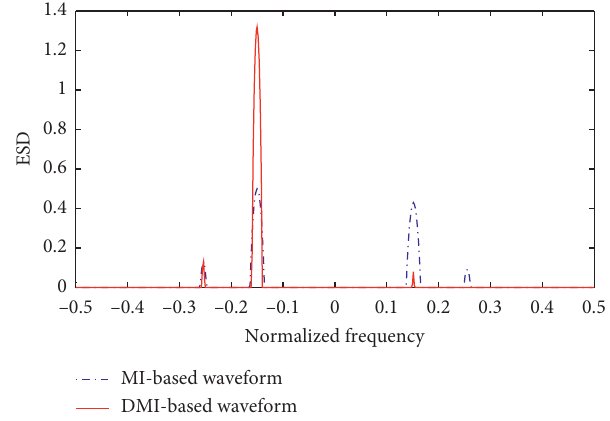
Figure 2: MI-based waveform and DMI-based